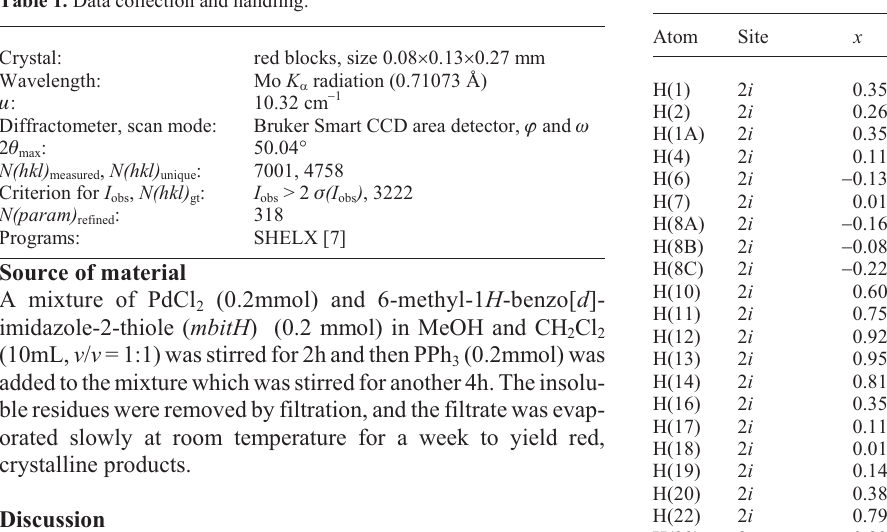
Intermolecular hydrogen bonds between the components lead to the formation of a one-dimensional chain along b . Table 2. Atomic coordinates and displacement parameters (in Å 2 )